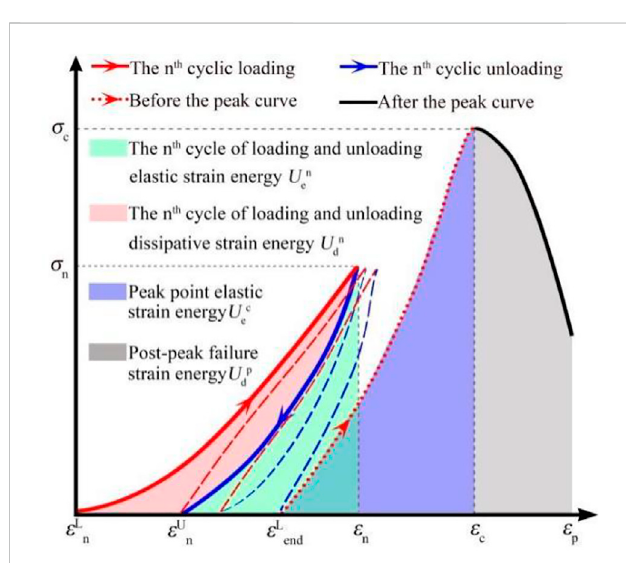
FIGURE 11 Schematic diagram of strain energy during cyclic loading and unloading of coal